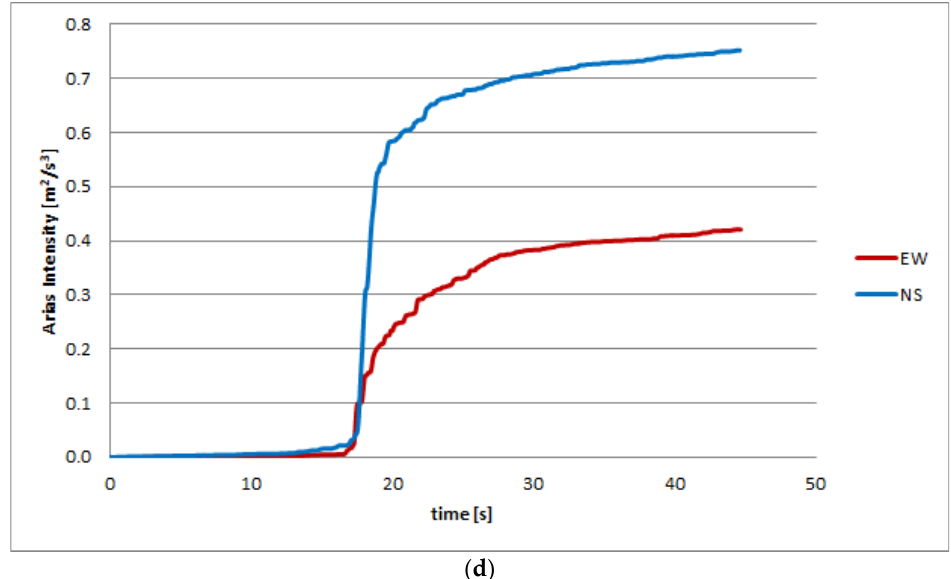
Figure 4. Vrancea earthquake of 4 March 1977 (M = 7,4 Richter Scale), INCERC monitoring station: ( a ) horizontal acceleration record from the NS direction; ( b ) horizontal acceleration record from the EW direction; ( c ) absolute acceleration spectrum of Figure 4a,b records and from P100-the Romanian seismic design code [18]; ( d )Arias intensity.